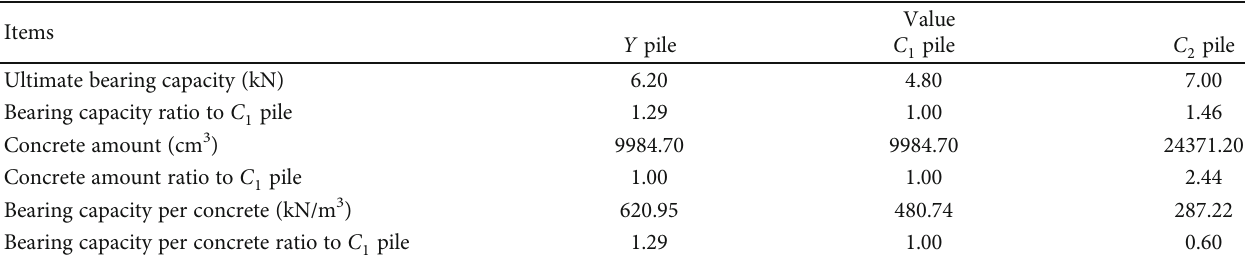
Table 4: Comparison of compressive loading tests.